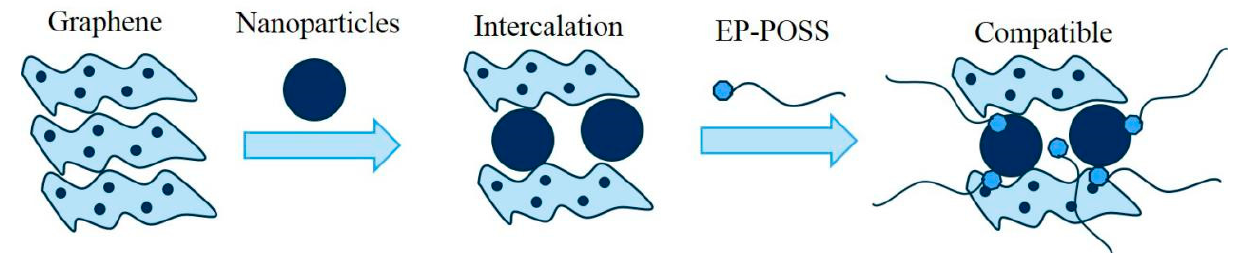
Figure 6. Compatibility model of the EP-POSS/graphene and nanoparticles.